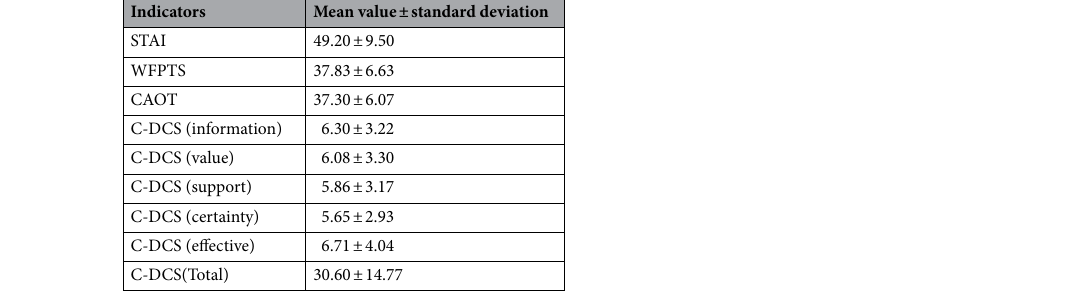
Table 2. Psychological indicators of proxies (n = 231).